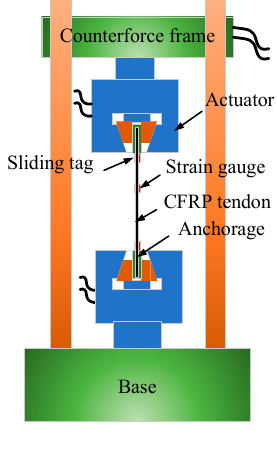
Figure 3. Fatigue test setup.